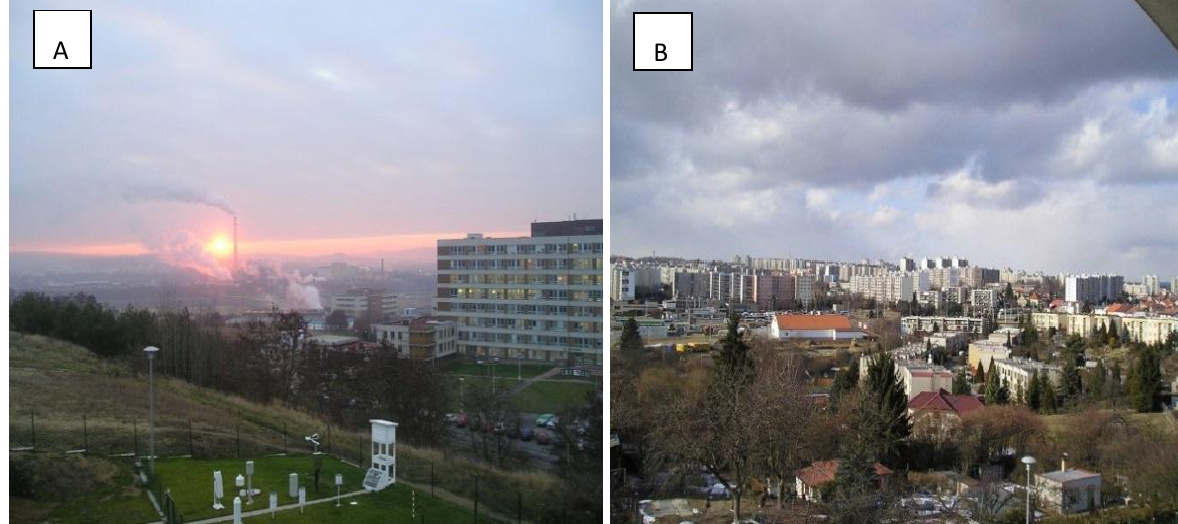
Fig. 5. Weather station in Pilsen-Mikulka. View from Southeast (A), view from Southwest (B) (source: CHMI)